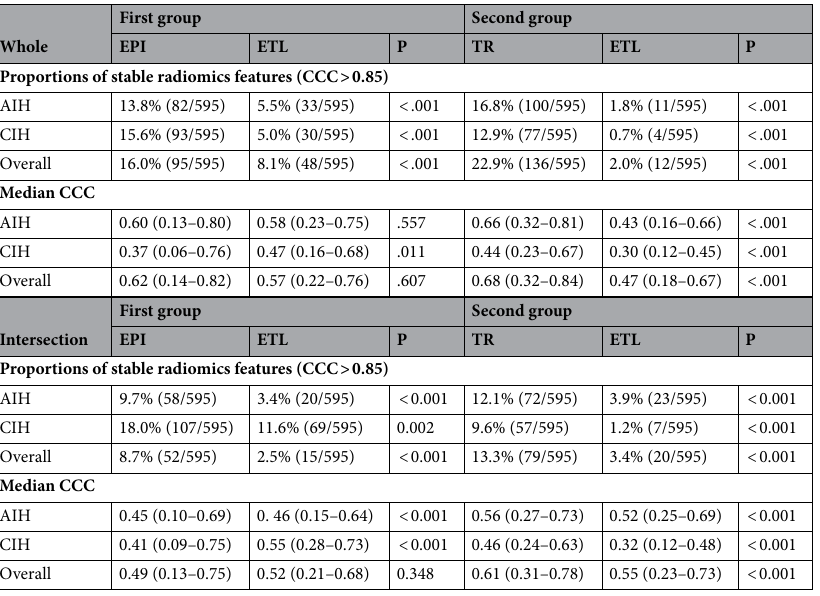
Table 1. Reproducibility of radiomics features in fast scanned T2-FLAIR compared with original T2-FLAIR as a reference standard. EPI echo-planar imaging, ETL echo train length, TR repetition time, P p value, CCC concordance correlation coefficients, AIH acute ischemic hyperintensity, CIH chronic ischemic hyperintensity. Parentheses indicate numbers of radiomics features in proportions of stable radiomics features or indicate 95% confidence